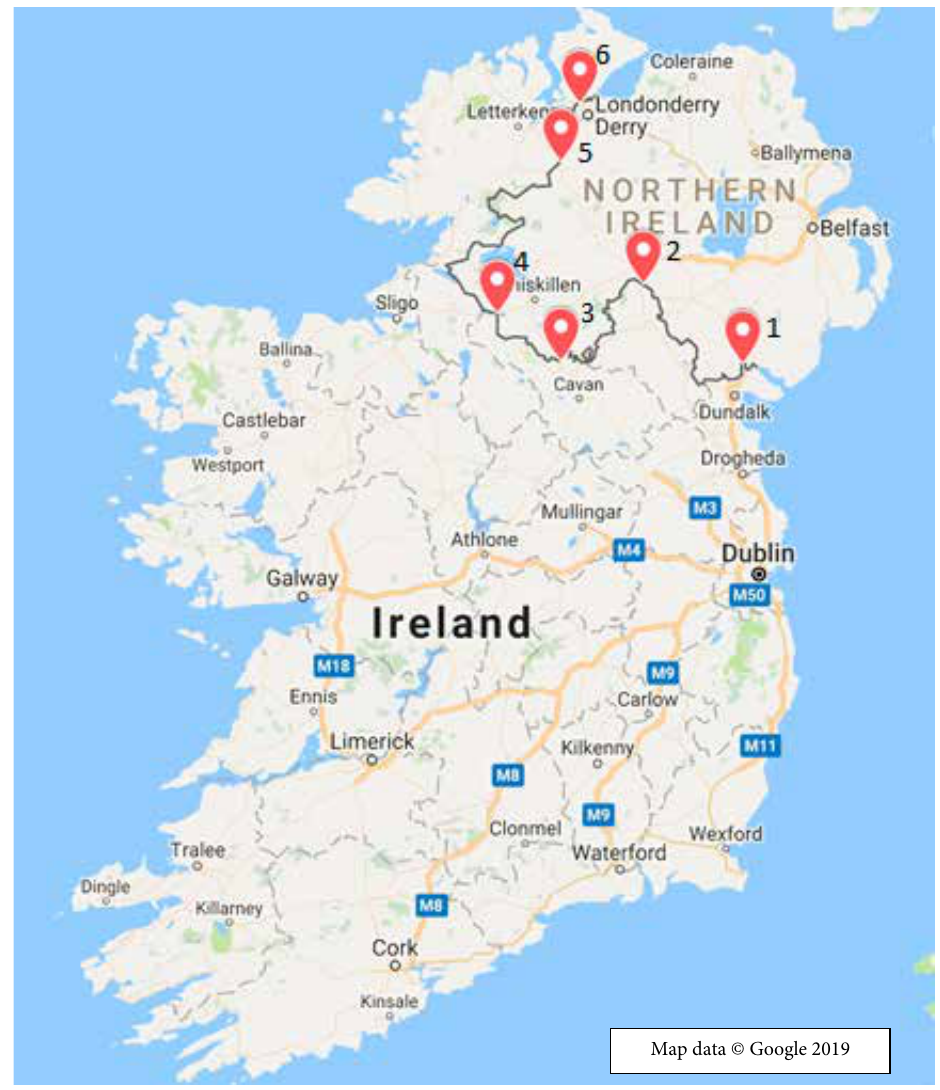
Figure 5: Locations of crossings points to be modeled [22].